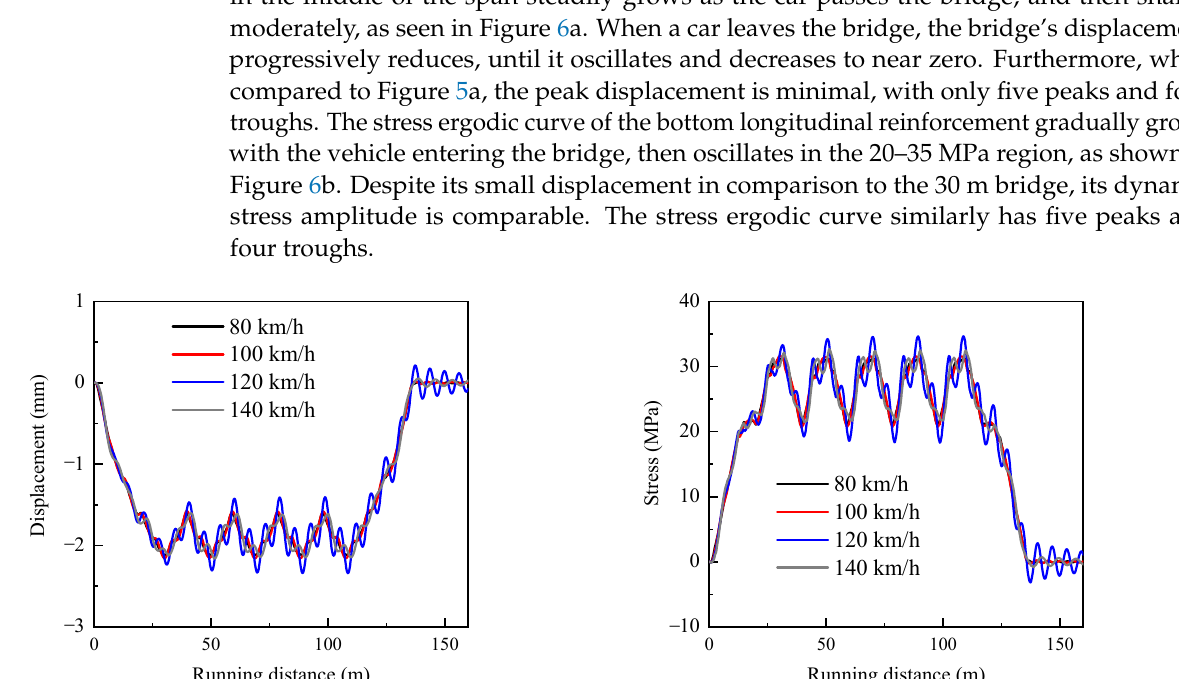
Figure 5. Time–history response curves of midspan of 30-m bridge.